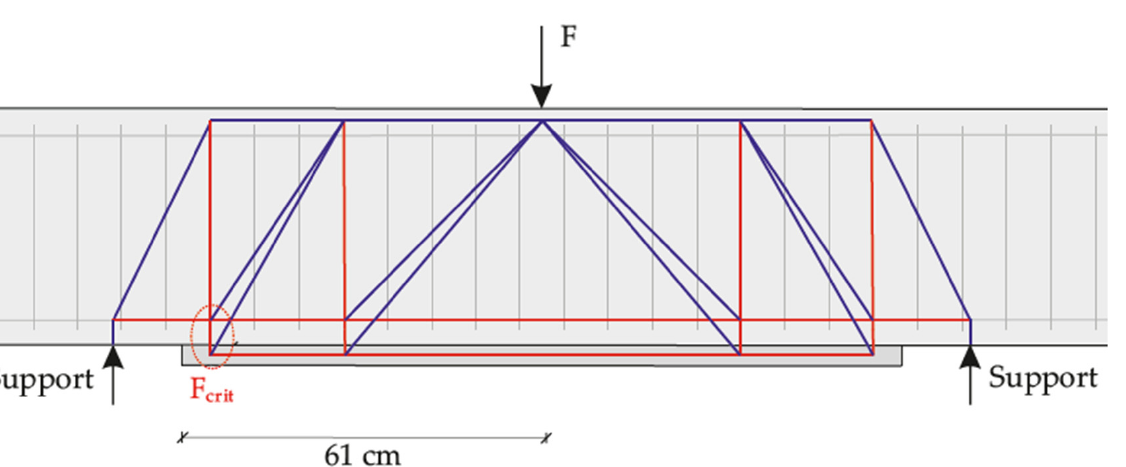
Figure 12. Strut-and-tie-model for the calculation of the critical tensile force, that induced concrete cover separation. (Graphic: CARBOCON GMBH).